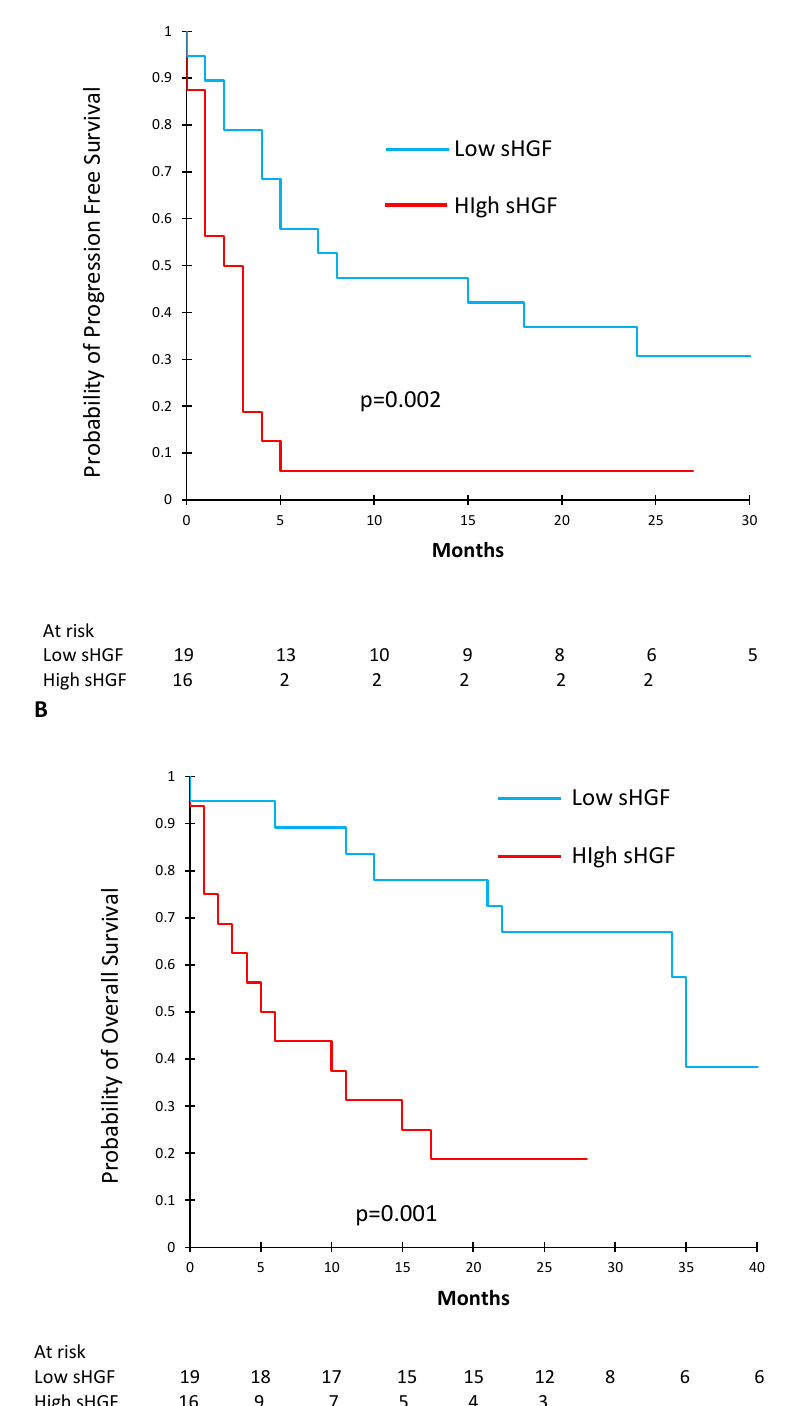
Figure 3. Kaplan–Meier curves showing progression free survival (PFS) ( A ) and overall survival ( B ) according to baseline sHGF